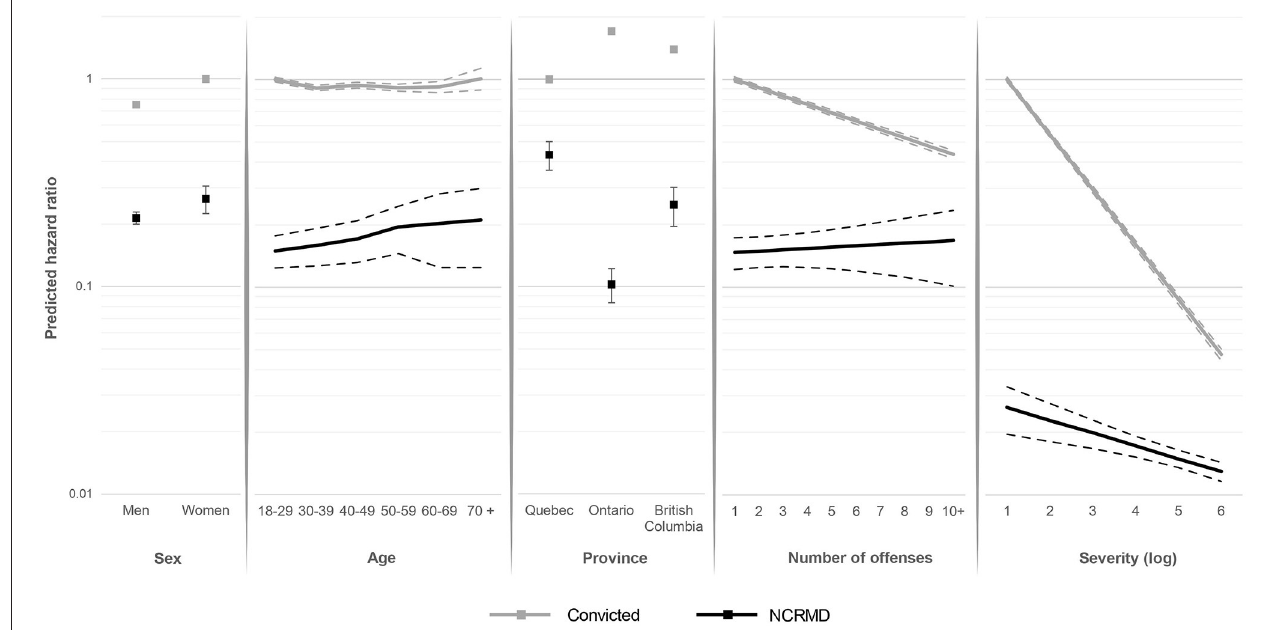
FIGURE 3 | Predicted odds of being released from detention over time for NCRMD and convicted offenders by sex, age, province, number of offenses, and offense severity a . – Represent confidence